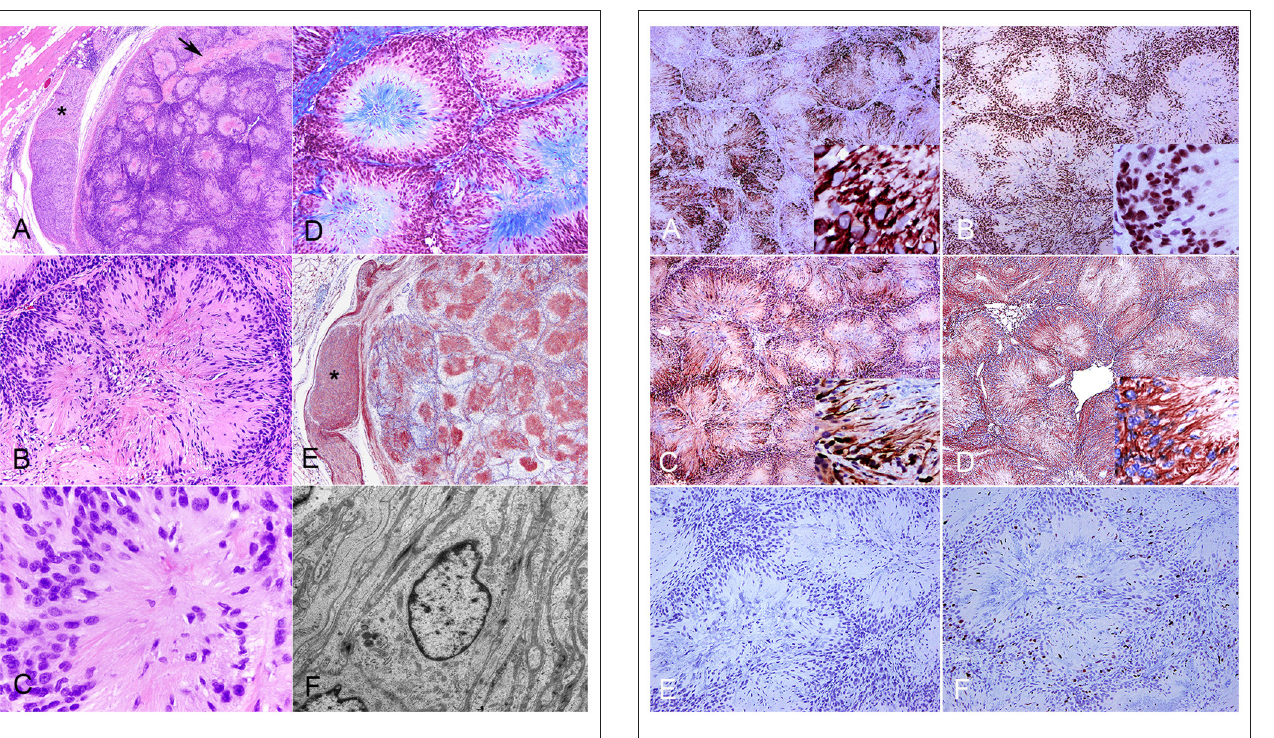
FIGURE 1 | Neuroblastoma-like schwannoma, cat, subcutaneous mass. The mass is composed of multiple lobules that are separated by variably thick bands of dense connective tissue (arrow). Note the hypercellular peripheral nerve fascicles (asterisk) in the vicinity of the mass, which is partially encapsulated by the epineurium. H&E stain (A) . The lobules are composed of multiple, tightly packed, 5–300- µ m-in-diameter, fibrillar, giant rosettes that exhibited a characteristic cellular polarity with a peripheralized nucleus and centrally oriented cytoplasm. Note that there is nuclear palisading. H&E stain (B) . Each individual giant rosette is characterized by radially-arranged fusiform cells with round to oval, lymphocyte-like nuclei and eosinophilic fibrillary cytoplasm. H&E (C) . Giant rosettes contain a centralized collagen core (in blue). Masson’s trichrome stain (D) . Each fibrillar and eosinophilic cytoplasmic neoplastic process, similar to each Schwann cell in healthy peripheral nerves (asterisk), diffusely and strongly immunoreacts to laminin. Immunohistochemistry for laminin (E) . Each neoplastic cell is coated by a well-formed, continuous, 50nm thick, electron-dense basal lamina investing long and interdigitating cytoplasmic processes. The cytoplasm contains a flattened, often invaginated nucleus, microfibrils and sparse organelles with a few mitochondria, ribosomes, and lysosome-like granules. TEM micrograph (F) .